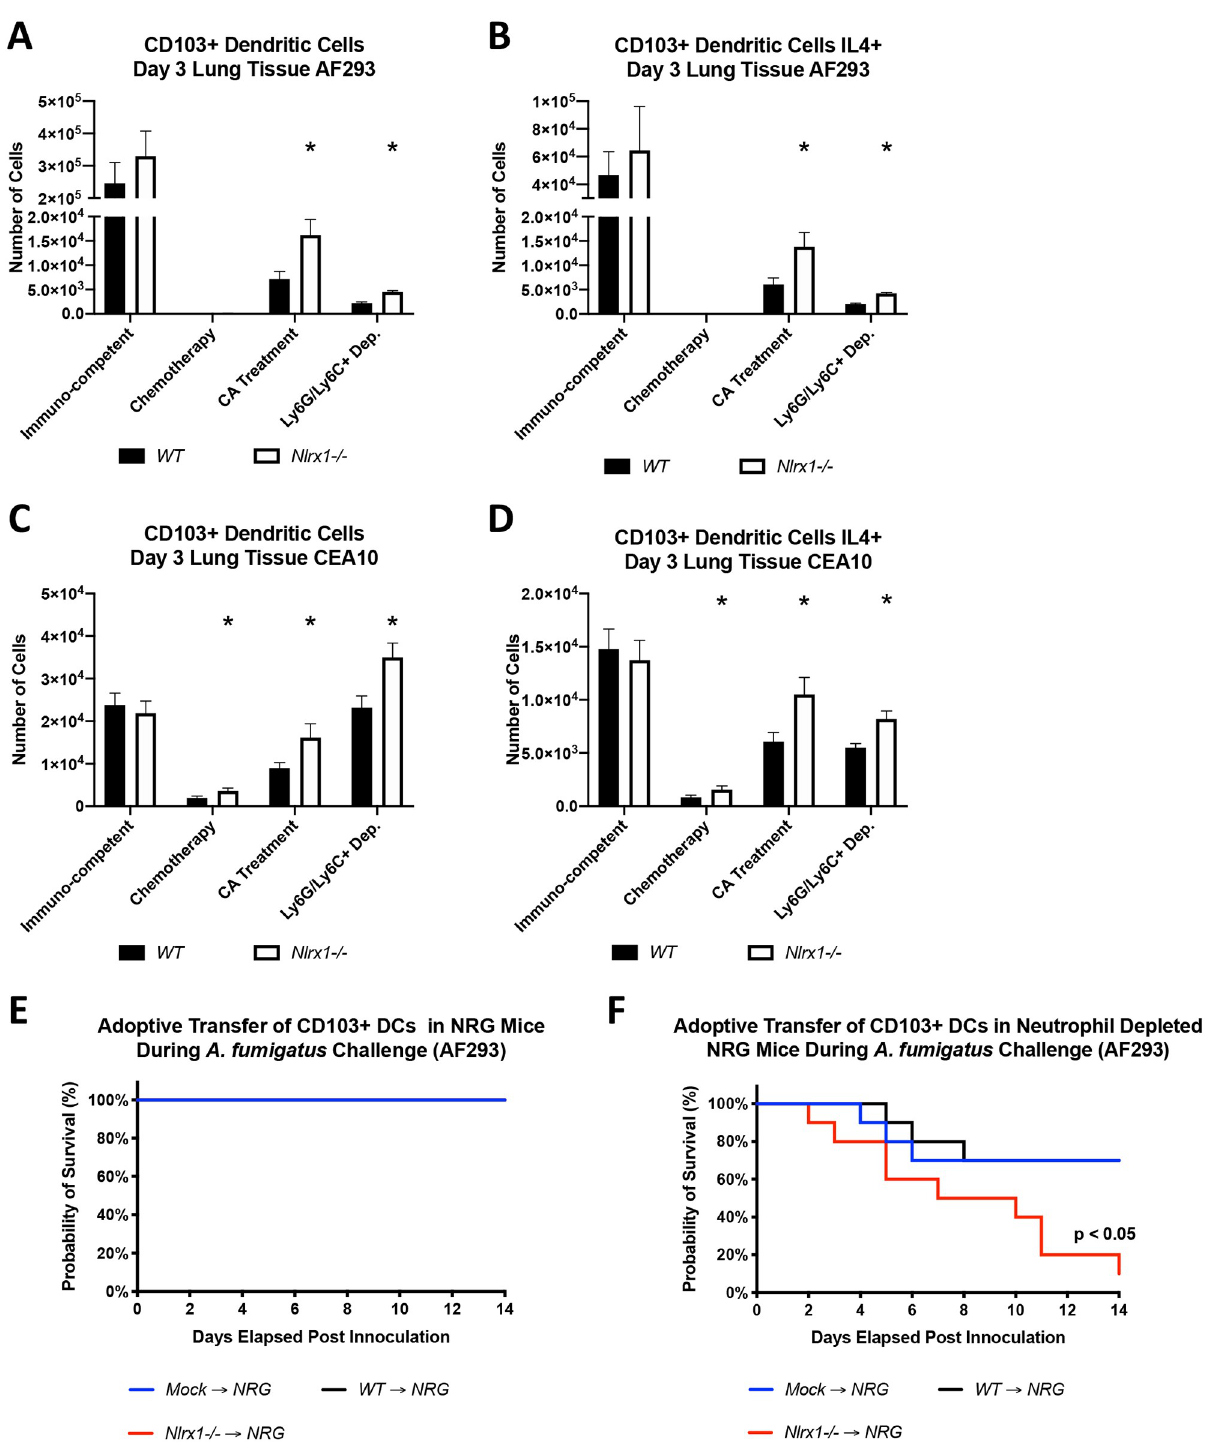
Fig 5. Characterization of pulmonary tissue dendritic cell populations and their adoptive transfer into NRG mice. (A-D) Freshly harvested conidia from either the AF293 or CEA10 isolate were delivered via aerosolization (12 mL, 1 X 10 9 conidia/mL) to wild type and Nlrx1-/- mice under immuno- competent or immuno-suppressive conditions including antibody based induction of neutropenia (Ly6G/Ly6C+ depletion), cortisone acetate (CA) treatment, and chemically induced leukopenia (Chemotherapy). Mice were sacrificed on day 3 post inoculation and the number of (AC) CD103+ DCs and (BD) those producing IL-4 was determined via flow cytometry. (A-D) Asterisk denotes statistical significance, P < 0.05 Mann-Whitney U test. Error bars indicate standard deviation. N = 6–10. (E) Survival study post adoptive transfer of wild type and Nlrx1-/- CD103+ dendritic cells into NRG